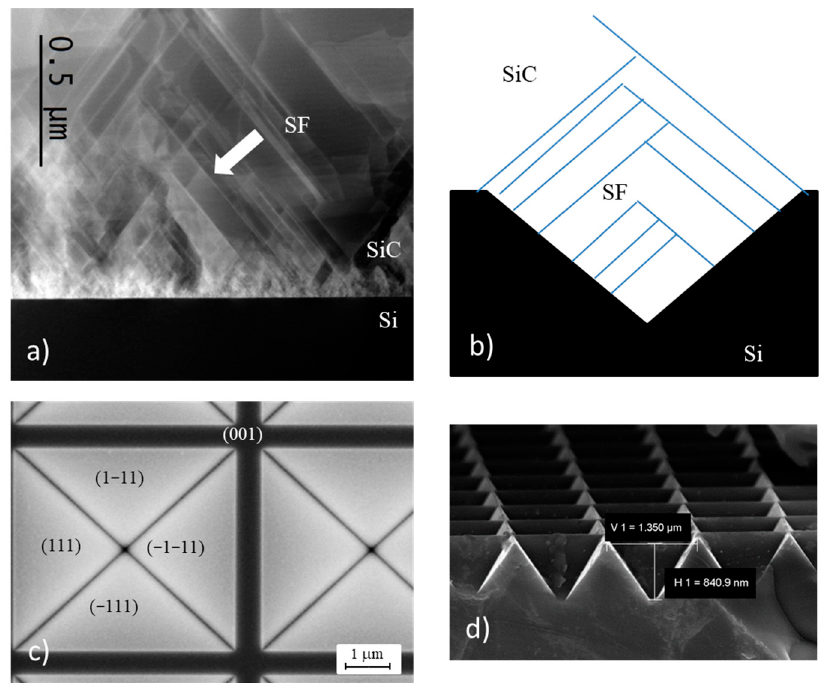
Figure 1. ( a ) Scanning TEM cross-section image of cubic silicon carbide (3C-SiC) grown on a flat silicon wafer. Bright lines indicated by the arrow are stacking faults (SFs); ( b ) pictorial cross-section view of SF self-annihilation mechanism. The black region represents silicon while white SiC. Blue lines are SFs; ( c ) SEM plan view of the 5 × 5 µ m 2 pyramid. The four (111) planes of the pyramid are indicated together with the (001) zone between two pyramids; ( d ) Cross view SEM image of 1 × 1 µ m 2 pyramid.